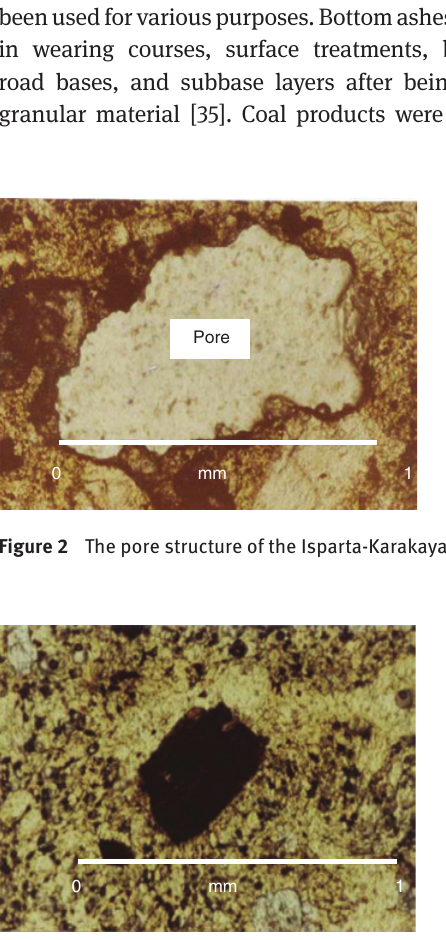
Figure 3 Opaque minerals within the Isparta-Karakaya pumice.